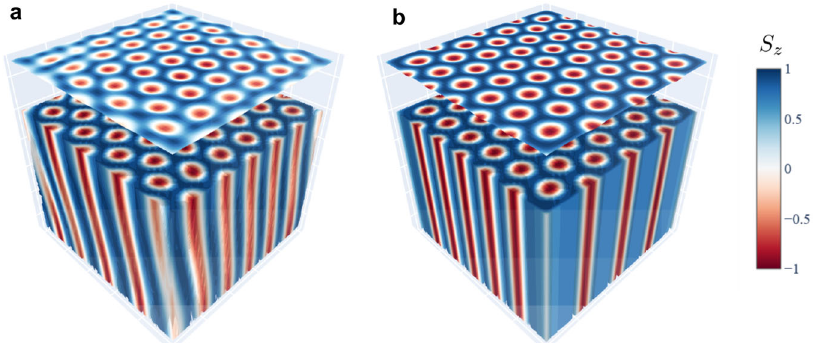
Fig. 5 Three-dimensional pro fi le of boundary fractional (anti)skyrmions. Three-dimensional magnetic con fi guration of con fi ned skyrmion lattices obtained by atomistic spin Monte Carlo simulations with ( a ) bulk DMI, characteristic of B20 materials, and ( b ) with D 2d DMI, typical of Heuslers. The average of the out-of-plane spin components over the sample thickness is displayed atop the skyrmion lattices. Skyrmionic objects exhibit a vertical tubular structure in Heuslers allowing their clear observation via imaging techniques such as LTEM ( b ). The DMI in B20 materials, however, favors tilted skyrmionic tubes resulting in blurry images along the sample edge ( a ). This could explain why fractional skyrmions have not been detected in B20 materials by LTEM or similar imaging techniques. The dipolar interaction was not included. In the presence of the dipolar interaction, an equivalent result is obtained with a less pronounced tilting of the